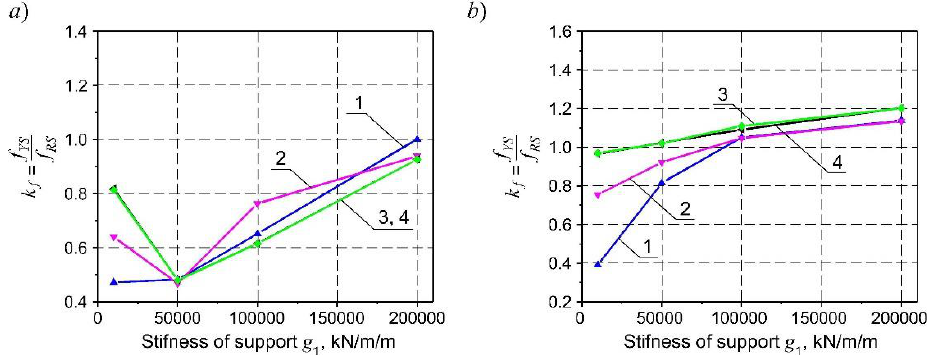
gg  ( a ) and 4 e l e l 12